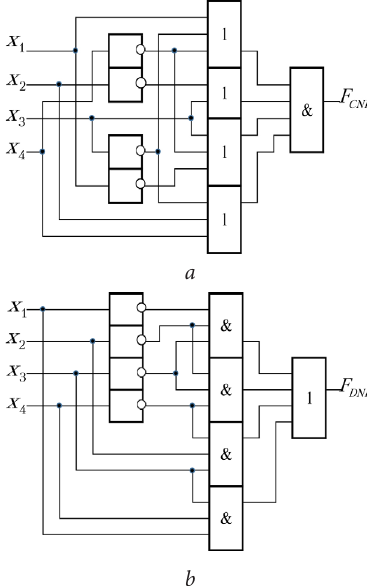
Fig. 2. The implementation of the minimum functions of the combinational circuit: a – CNF; b –